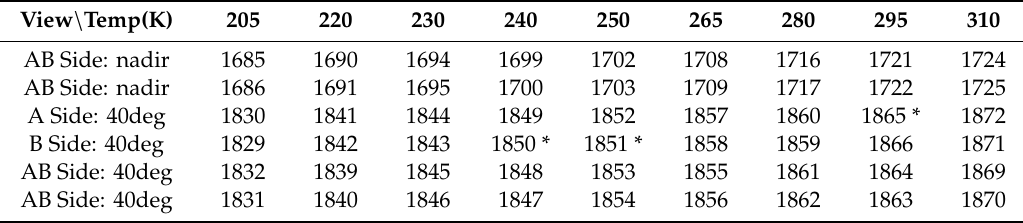
Table 6. Additional tests used for determining the AIRS V7 radiometric calibration coe ffi cients. View \